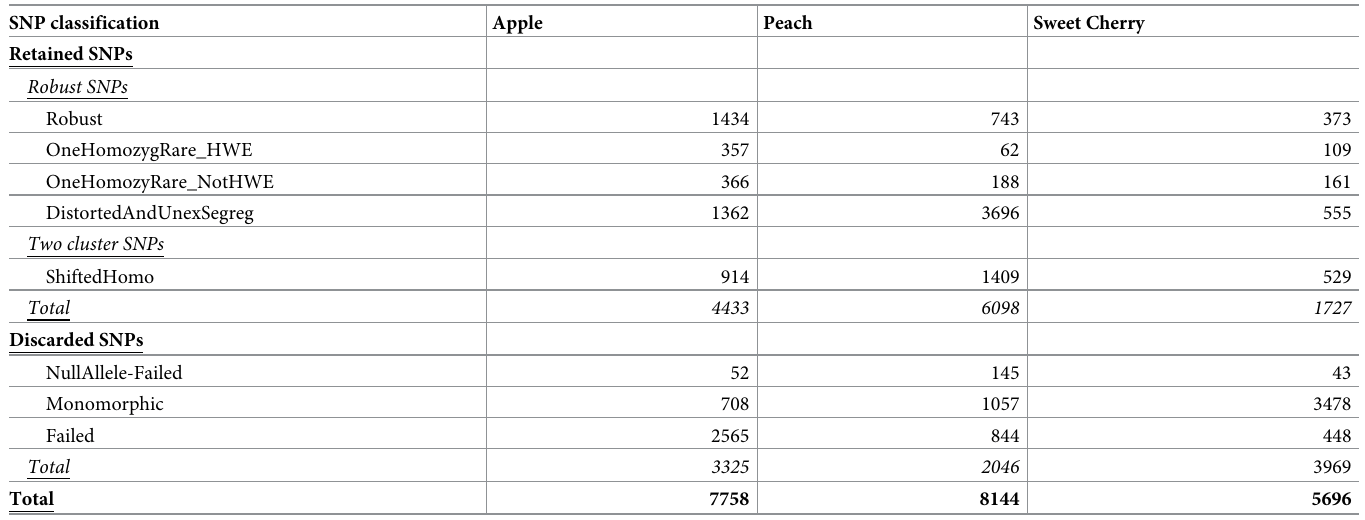
Table 2. Summary of SNP classification by ASSIsT for apple, peach, and sweet cherry. SNP classifications are grouped in retained and discarded SNPs.